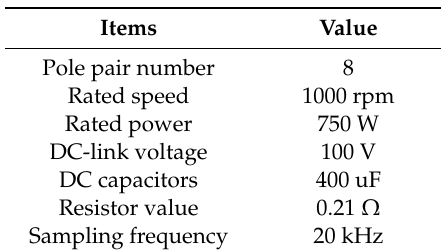
Figure 7. Current loop in different current loop. ( a ) (SA, Sa) = (4,2); ( b ) (SA, Sa) = (4,3); ( c ) (SA, Sa) = Figure7. Currentloopindi ff erentcurrentloop. ( a )(SA,Sa) = (4,2); ( b )(SA,Sa) = (4,3); ( c ) (SA, Sa) = (3,2); ( d ) (SA, Sa) = (3,4); ( e ) (SA, Sa) = (2,3); ( f ) (SA, Sa) = (2,4). (3,2); ( d ) (SA, Sa) = (3,4); ( e ) (SA, Sa) = (2,3); ( f ) (SA, Sa) = (2,4).